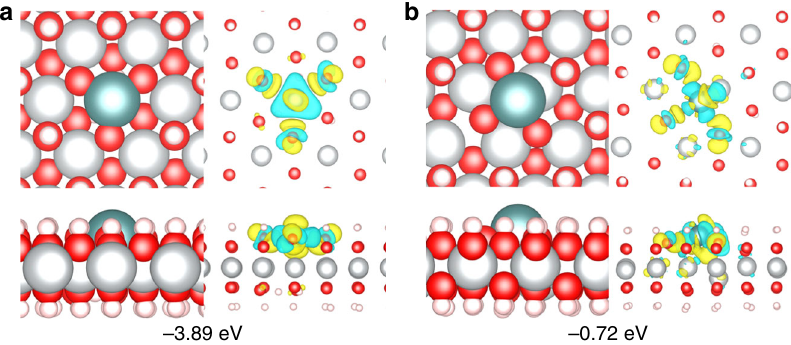
Fig. 5 Studies of the interaction between Ni 2 + vacancies and isolated Pt atoms. Top and side views of the most stable structure and charge density difference for the Pt atom adsorbed on the Ni(OH) 2 with Ni 2 + vacancies ( a ) and without Ni 2 + vacancies ( b ). The cyan, gray, red, and white balls refer to Pt, Ni, O, and H atoms, respectively. For charge density difference, yellow (blue) corresponds to charge accumulation (depletion) plotted with an isovalue of ±0.01 e Å −